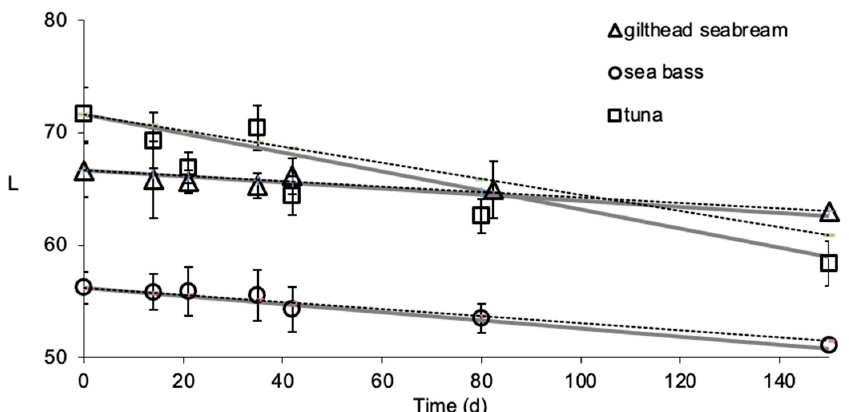
Figure 3. Comparison of experimental and predicted changes in L -value of thawed gilthead sea bream fillets, sea bass fillets and yellowfin tuna slices at non-isothermal conditions (Figure 2). The gray solid lines indicate predictions by Method #1, the black dashed lines indicate the predictions by Method #2, and the data points present the experimental values. (Error bars indicate standard error of measurements of three different samples.) Table 2. Performance evaluation of the mathematical models for the quality parameters of frozen